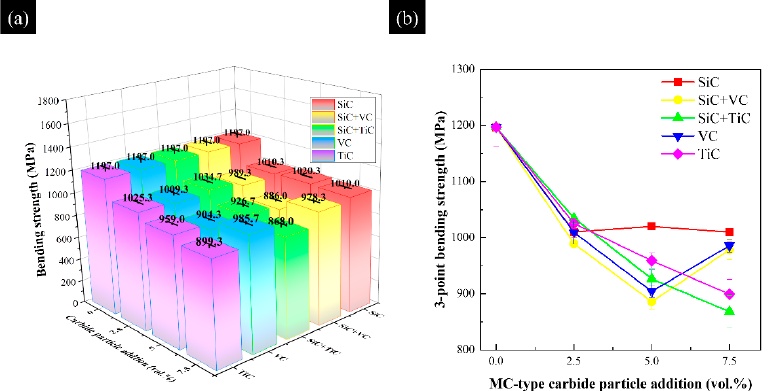
Figure 9. The effect of the volume fraction and type of additive MC-type carbides on the 3-point bending strength of designed MMCs. ( a ) Histograms of 3-point bending strength vs. volume fraction and type of carbides; ( b ) Curves of 3-point bending strength vs. MC-type carbides addition.